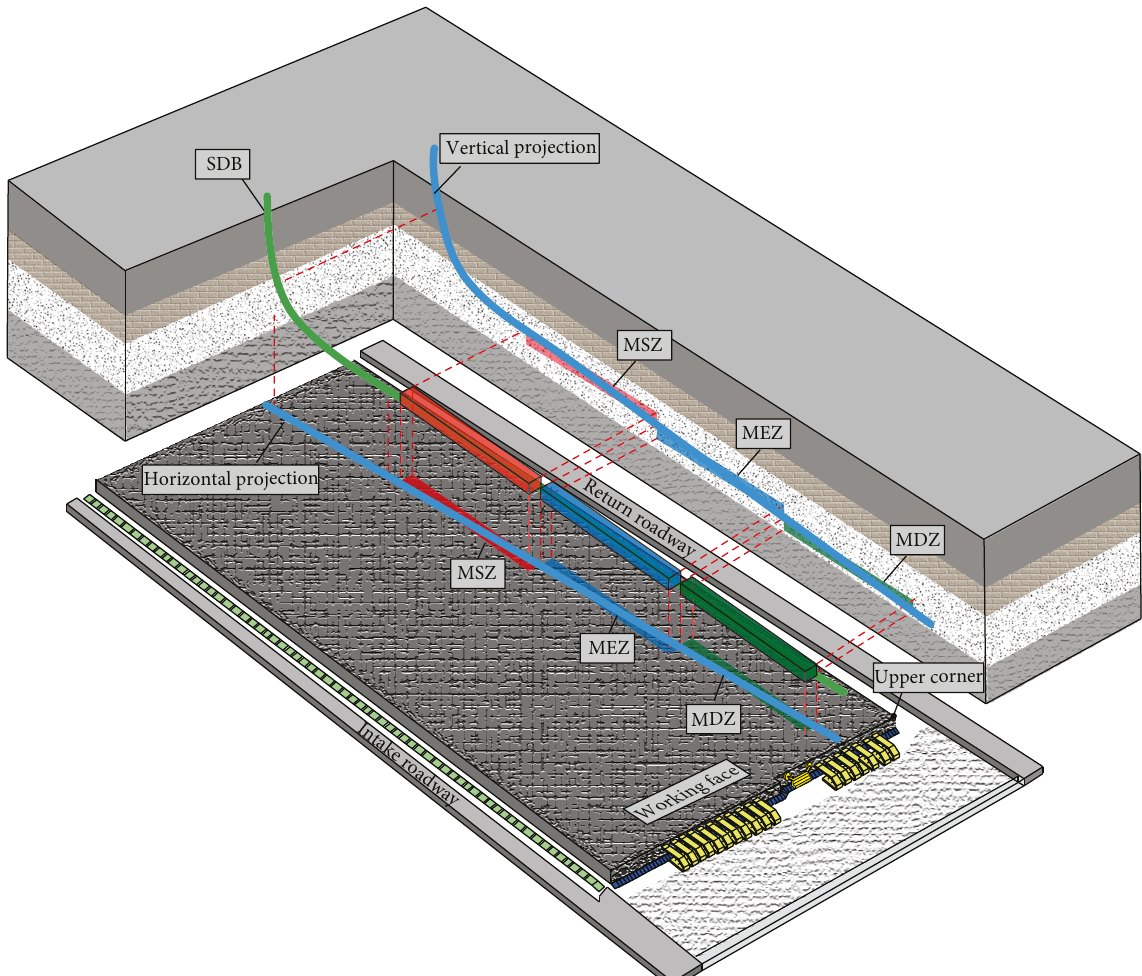
Figure 8: Space locations of the MDZ, MEZ, and